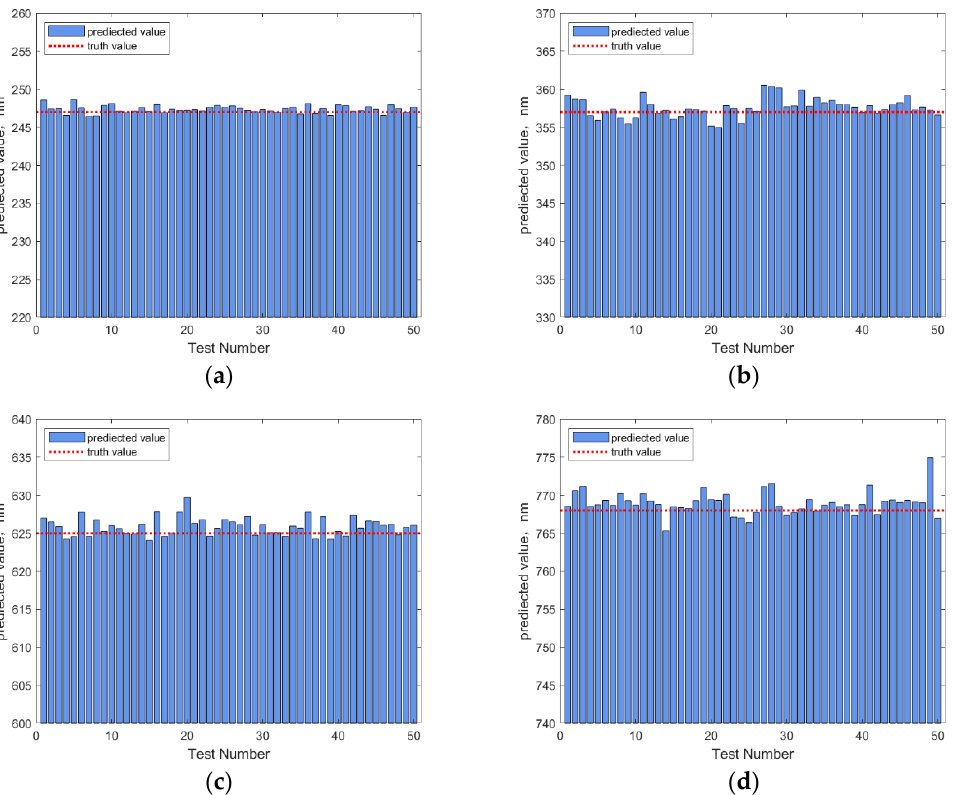
Figure 12. Four measuring examples on the test set. ( a ) Linewidth of 247 nm. ( b ) linewidth of 357 nm. ( c ) linewidth of 625 nm and ( d ) linewidth of 768 nm.